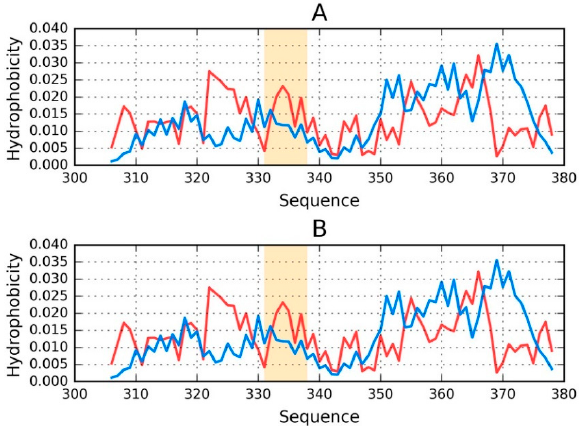
Figure 3. Theoretical (T—blue) and observed (O—red) distributions for phf-tauO: ( A ) chain E treated as a distinct structural unit; and ( B ) chain F treated as a distinct structural unit. Orange highlighting marks residues which comprise the inter-fibril interface (331–338).